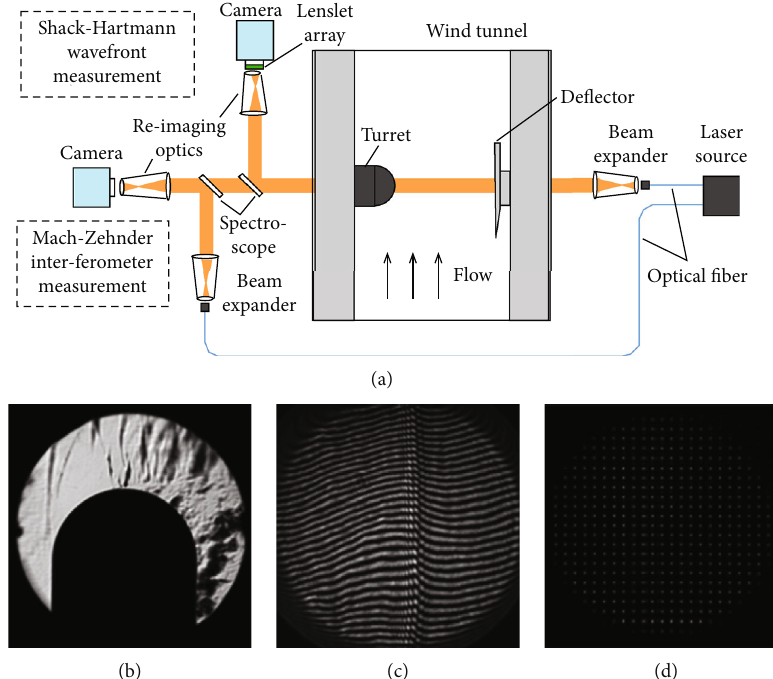
Figure 3: (a) Experimental schematic and images for (b) schlieren ( Ma = 0 : 65 ), (c) Mach-Zehnder interferometer, and (d) Shack-Hartmann subaperture